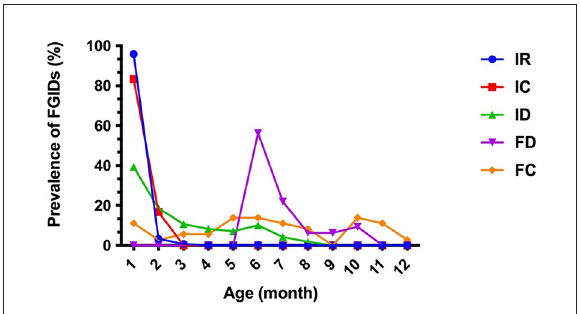
FIGURE1 Trend of prevalence of FGIDs in infants aged from 1 to 12 months old. IR, infant regurgitation; IC, infant colic; ID, infant dyschezia; FD, functional diarrhea; FC, functional